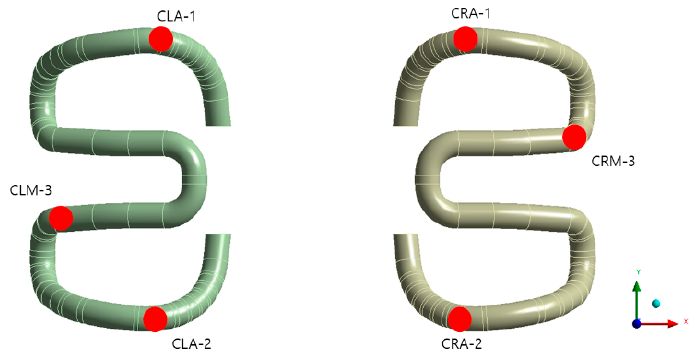
Figure 10. Positions defined for stress evaluation.